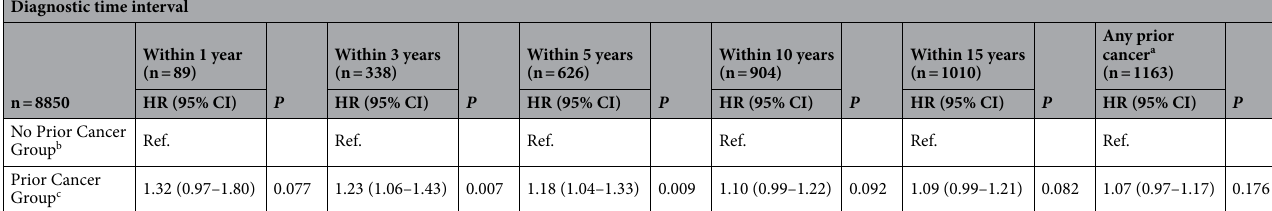
were performed to examine the heterogeneous effects of prior cancers according to their characteristics (Fig. 3). Here, we categorized prior cancers according to smoking-relatedness (Model 1), prognosis (Model 2), and stage